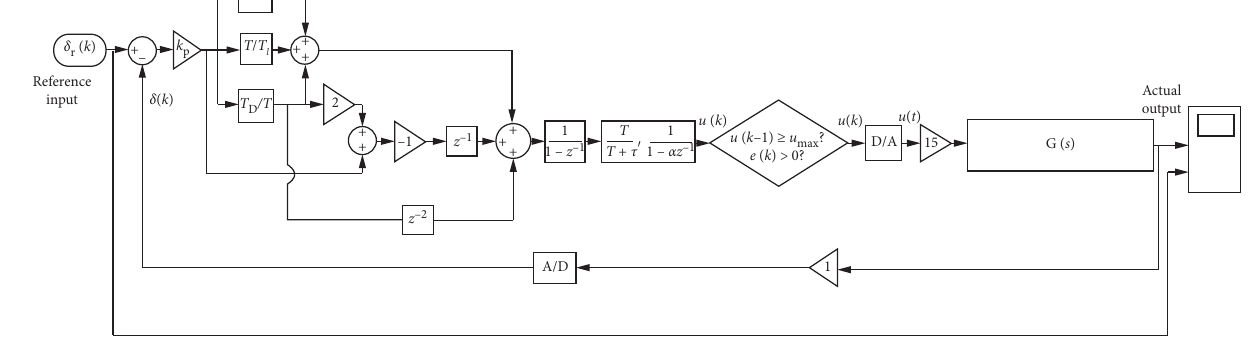
Figure 6: Simulation of improved PID control.